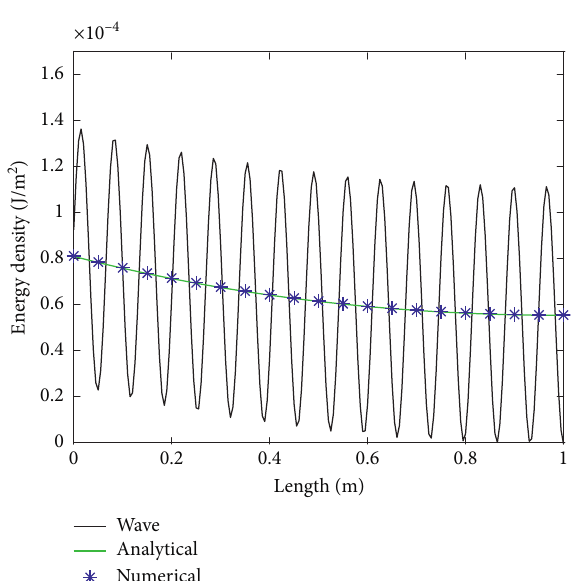
Figure 4: Energy densities of the rod in space. Figure 11. It is observed that, for the beam, results from the proposed analytical method and the numerical method coincide well and represent well the global variation in the classical wave solution regardless of the excitation frequency.